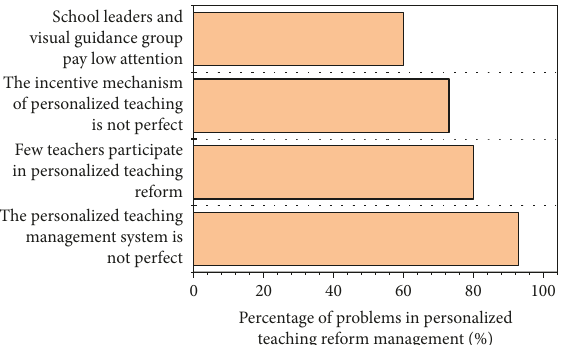
Figure 2: The proportion of problems existing in personalized teaching reform management.